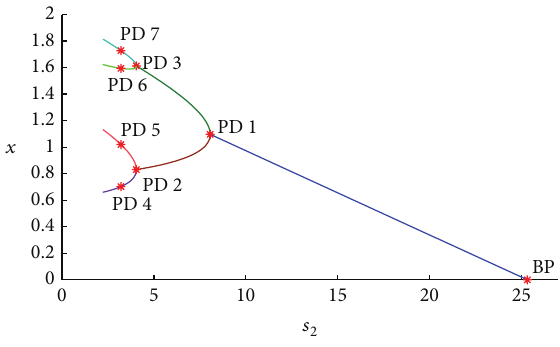
Figure 5: Continuation of 𝐸 1 in ( 𝑠 2 , 𝑥